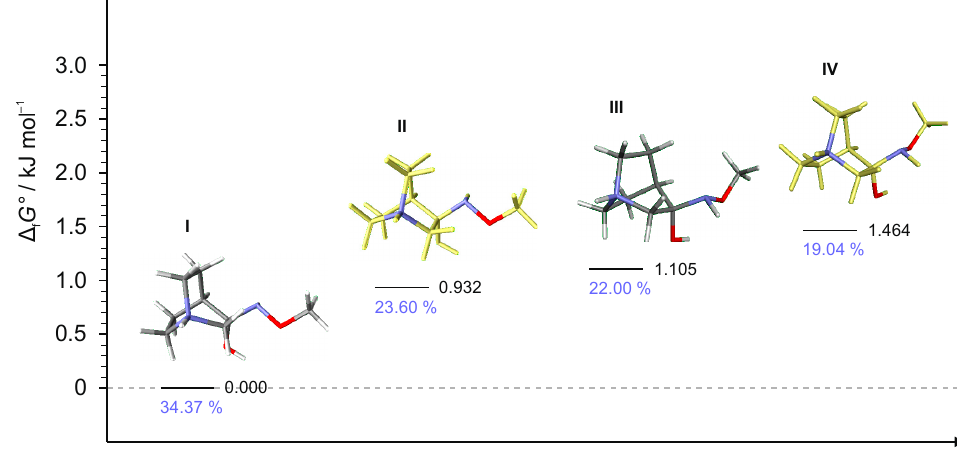
Figure 7. Four lowest energy conformers of 1·HCl and their relative standards Gibbs energies of formation Δ f G °calculated at the B3LYP-D3/6-311++G(d,p) level of the theory. (Relative fractions according to Boltzmann distribution at 298.15 K are given in blue.)